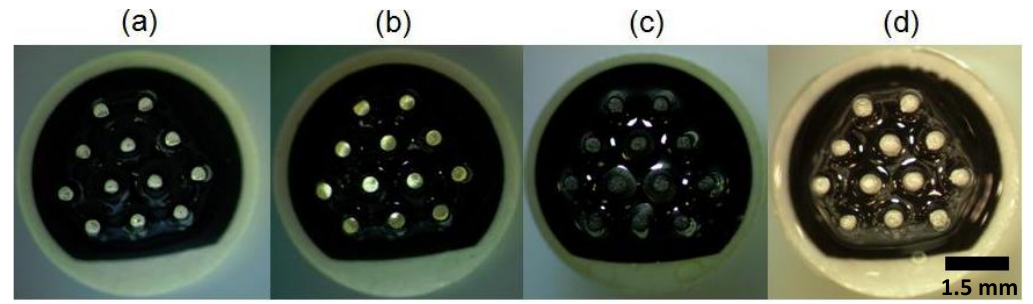
Figure 2. Array before polishing ( a ), after polishing ( b ), after spin coating of carbon ink ( c ) and after spin coating of Ag/AgCl ink ( d ).